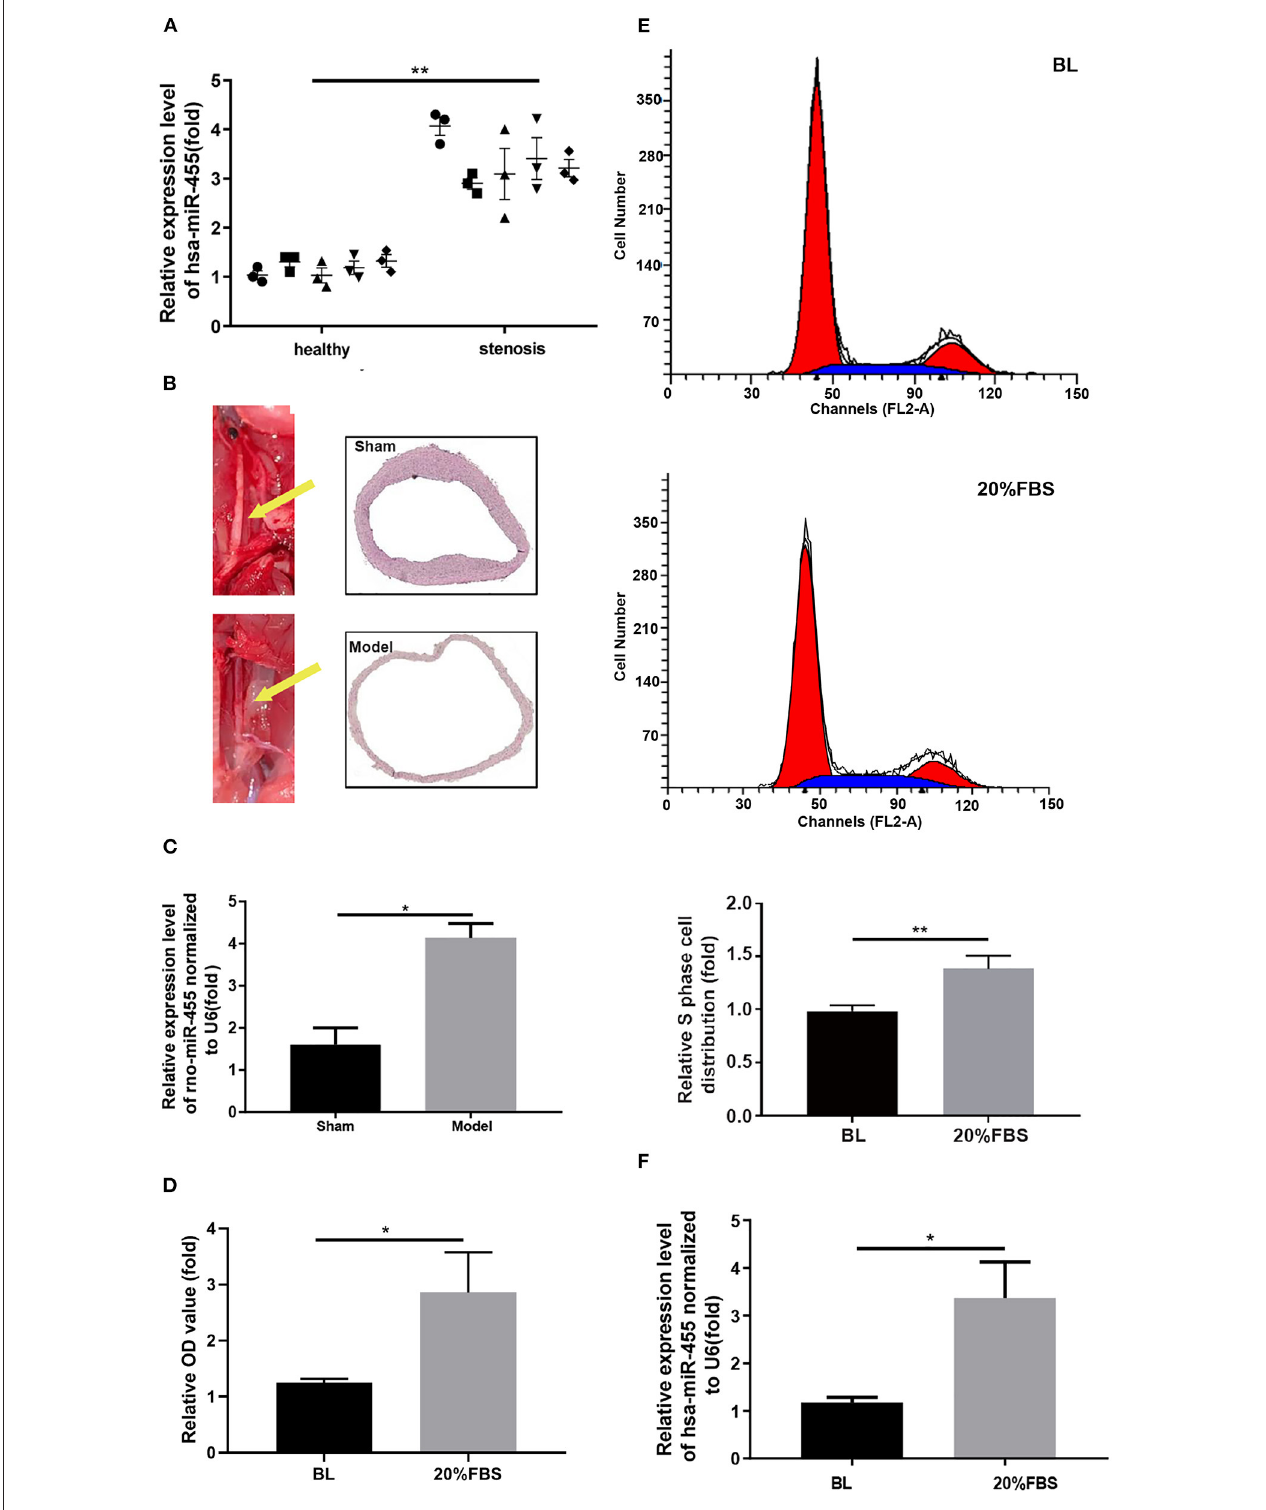
FIGURE 1 | (A) Expression levels of hsa-miR-455 in healthy (5) and stenotic (5) arteries examined by qRT-PCR. Hsa-miR-455 was normalized to U6. The first PCR value of the first normal sample was designated as 1. (B) The rat carotid artery balloon injury model. The left carotid artery (yellow arrow) was injured. (C)